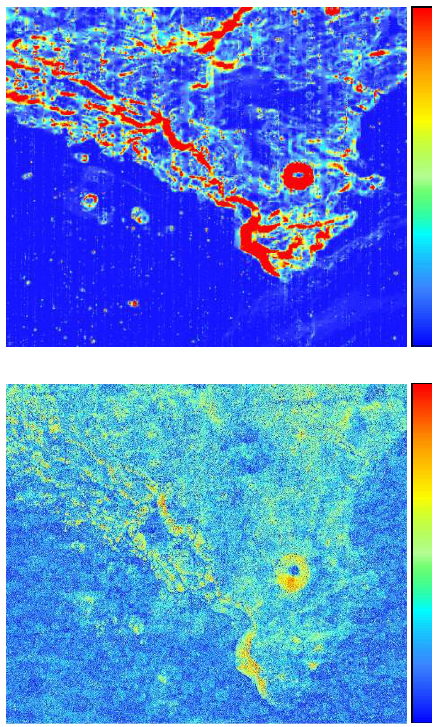
Figure 6. Results by using RMSH (up) and MSR (down) of the tail of Montes Jura